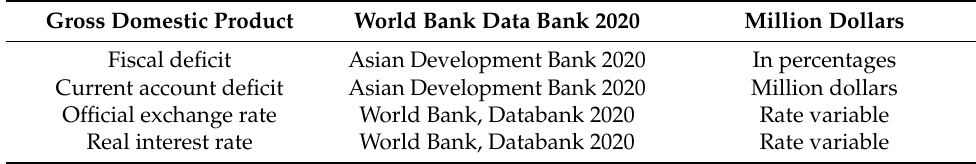
Table 4. Variables, Data Sources, and